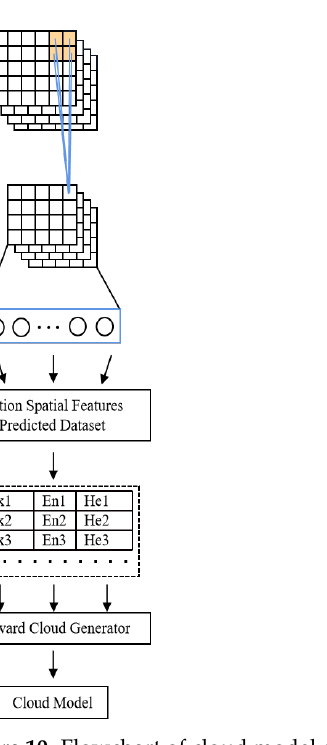
Figure 10. Flowchart of cloud model generation for predicting actions.